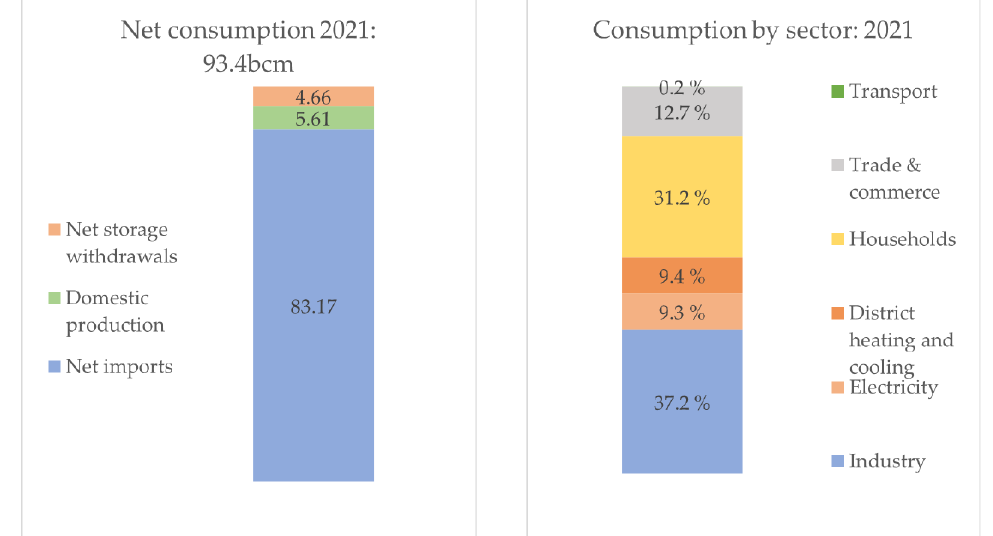
Figure 3. Supply sources of natural gas consumption in Germany in 2021 ( left ) and relative consumption share by sector ( right ). Source: [39]. Note that different publications show slight variations in the consumption share of sectors. For details see: [6,40–42].